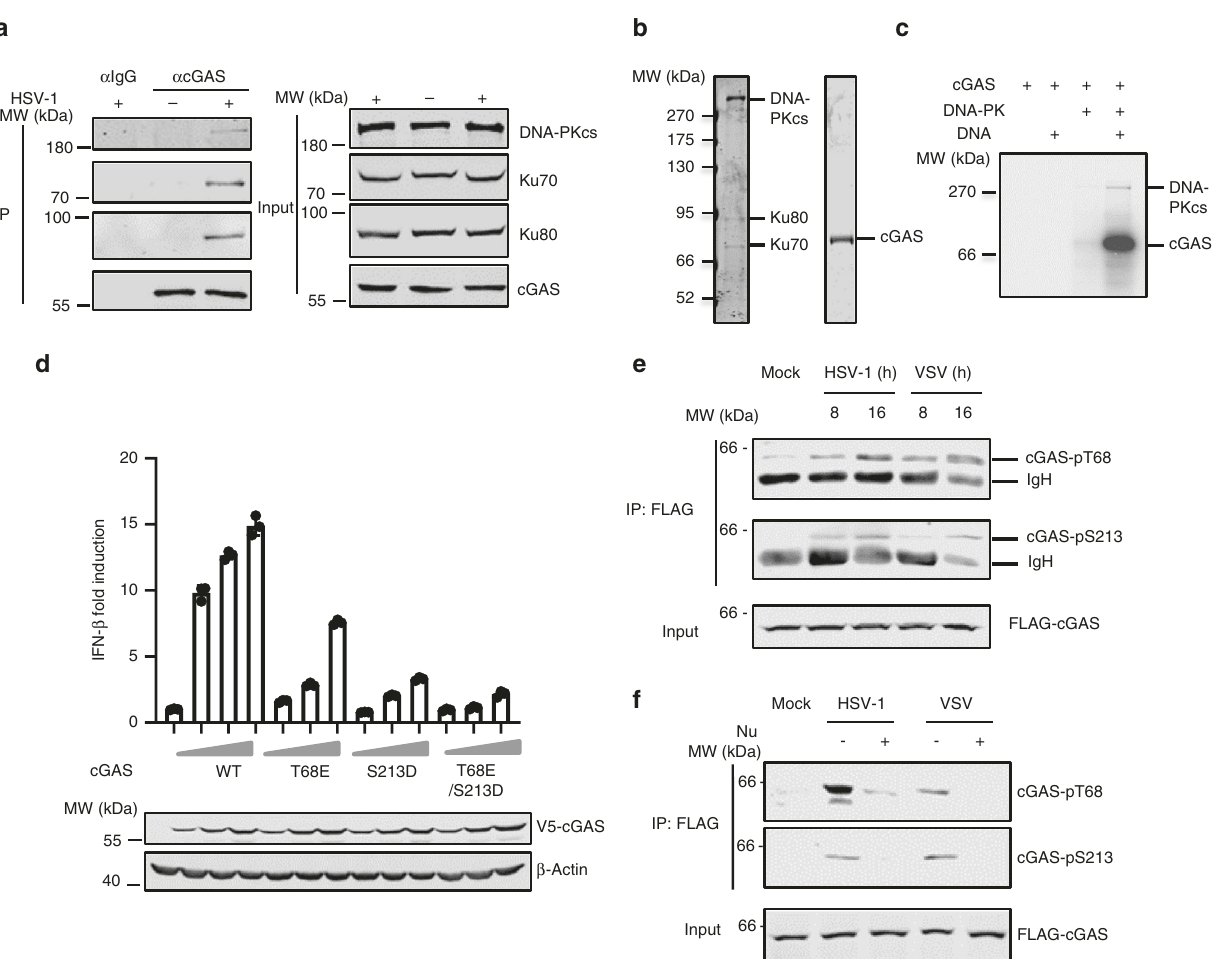
Fig. 4 DNA-PK phosphorylates cGAS. a THP-1 cells were mock infected or infected with HSV-1 (MOI = 0.01) for 16 h before co-immunoprecipitation and immunoblotting analysis. b DNA-PK complex and puri fi ed cGAS were analyzed by silver staining. c In vitro kinase assay was performed using DNA-PK complex and puri fi ed cGAS with or without HT-DNA (1 μ g/ml). d 293T cells were transfected with an IFN- β reporter plasmid cocktail with plasmids containing cGAS WT or the mutants and STING. IFN- β activation was determined by luciferase assay. e THP-1 cells stably expressing FLAG-cGAS were mock infected or infected with HSV-1 (MOI = 1) or VSV (MOI = 0.1). WCLs were collected at the indicated hpi and precipitated with anti-FLAG agarose. Precipitated proteins and WCLs were analyzed by immunoblotting with the indicated antibodies. f THP-1 cells stably expressing FLAG-cGAS were mock infected or infected with HSV-1 (MOI = 1) or VSV (MOI = 0.1) and were mock treated or treated with Nu7441 (3 μ M). WCLs were collected at 16 hpi and precipitated with anti-FLAG agarose. Precipitated proteins and WCLs were analyzed by immunoblotting with the indicated antibodies. All experiments were done at least twice, and one representative is shown. n = 3 biologically independent samples for d . Data are presented as mean values ± SD. Source data are provided as a Source data fi Fig. 4g). Remarkably, Nu7441 treatment signi fi cantly blunted cGAS phosphorylation at T68 and S213 induced by HSV-1 and VSV (Fig. 4f), supporting the conclusion that cGAS is phosphorylated by DNA-PK at T68 and S213 in virus-infected cells. Together, these results demonstrate that DNA-PK phos- phorylates cGAS at T68 and S213 upon VSV and HSV-1 infection to dampen cGAS-mediated innate immune signaling.